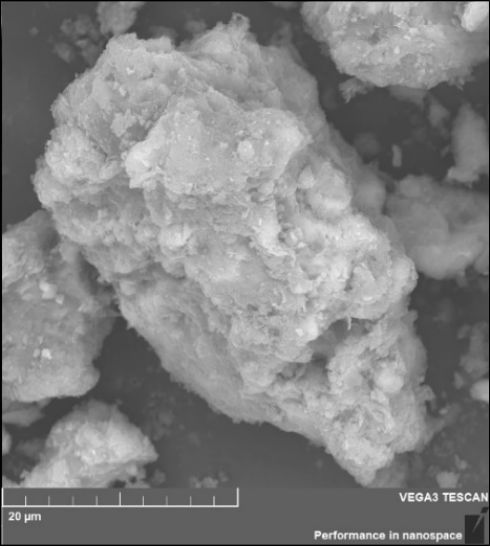
Figure 7. Cohesive soil aggregates.